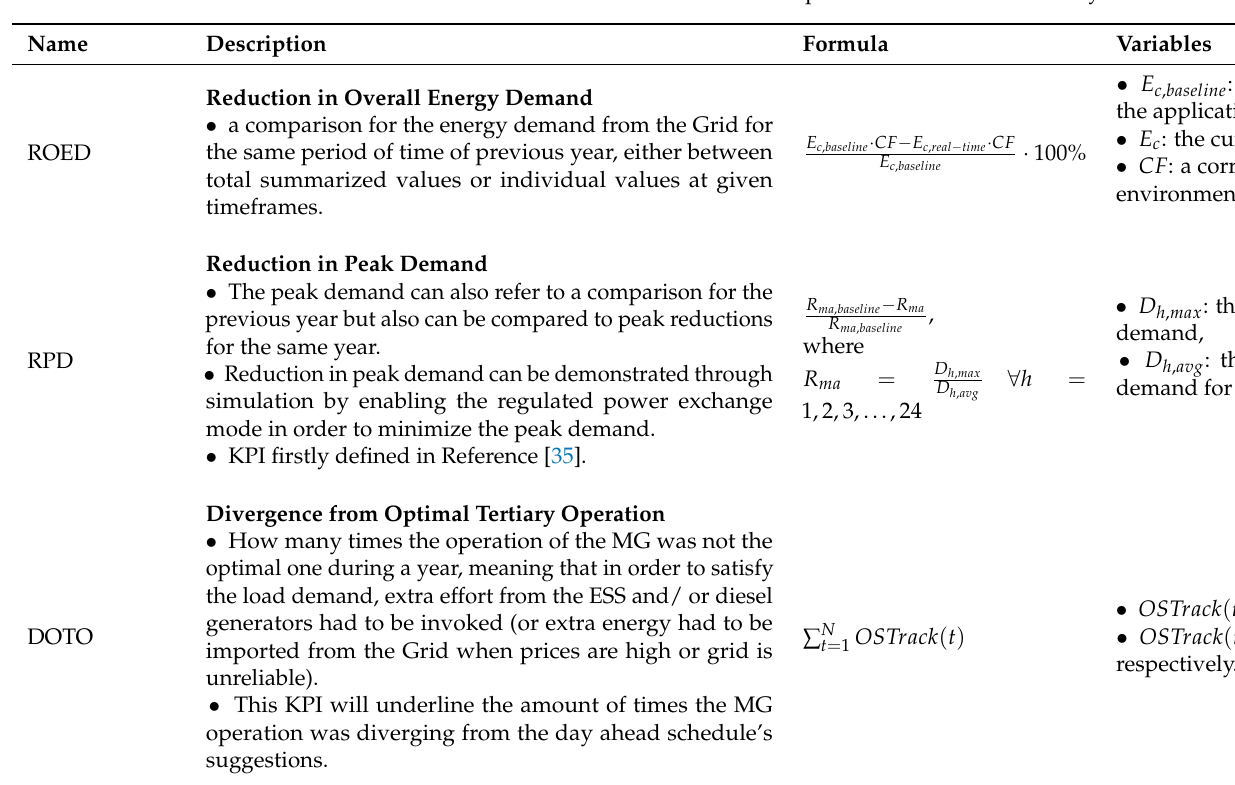
Table A6. Detailed Representation of MG Efficiency